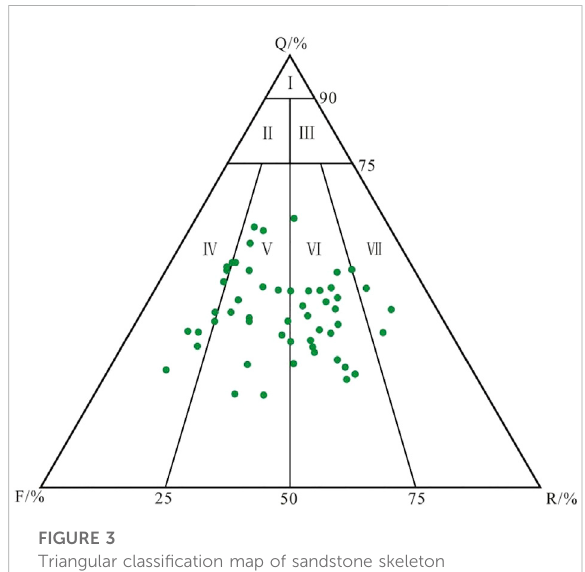
FIGURE 3 Triangular classi fi cation map of sandstone skeleton composition in deep low-permeability reservoirs in